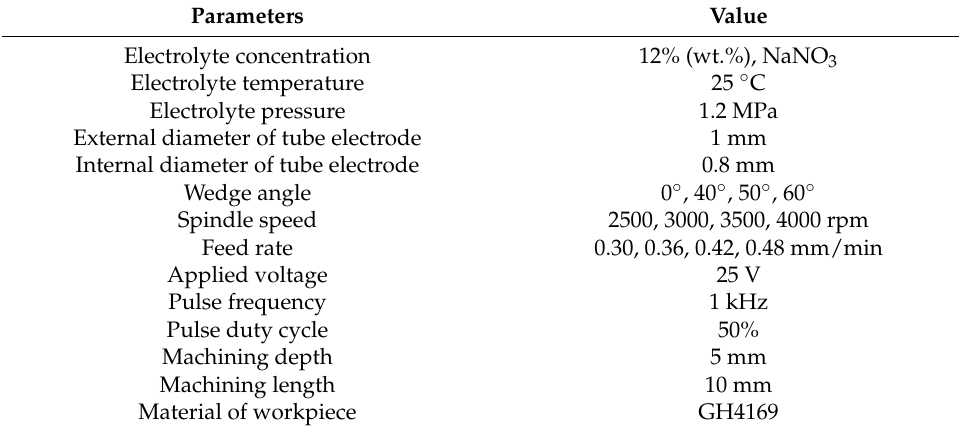
Figure 8. Schematic diagram of deep-narrow groove measurement. Table 2. Machining parameters.